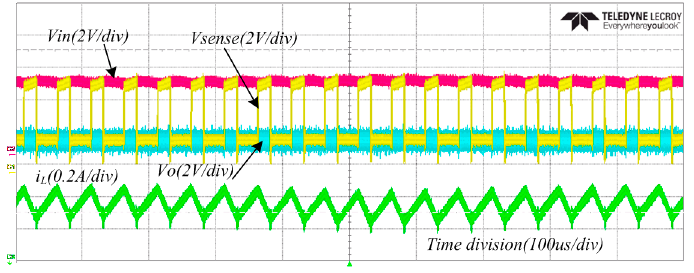
Figure 13. Experimental waveforms for the current, estimated input and output voltages, and the sensed voltage, as highlighted in Figure 5.